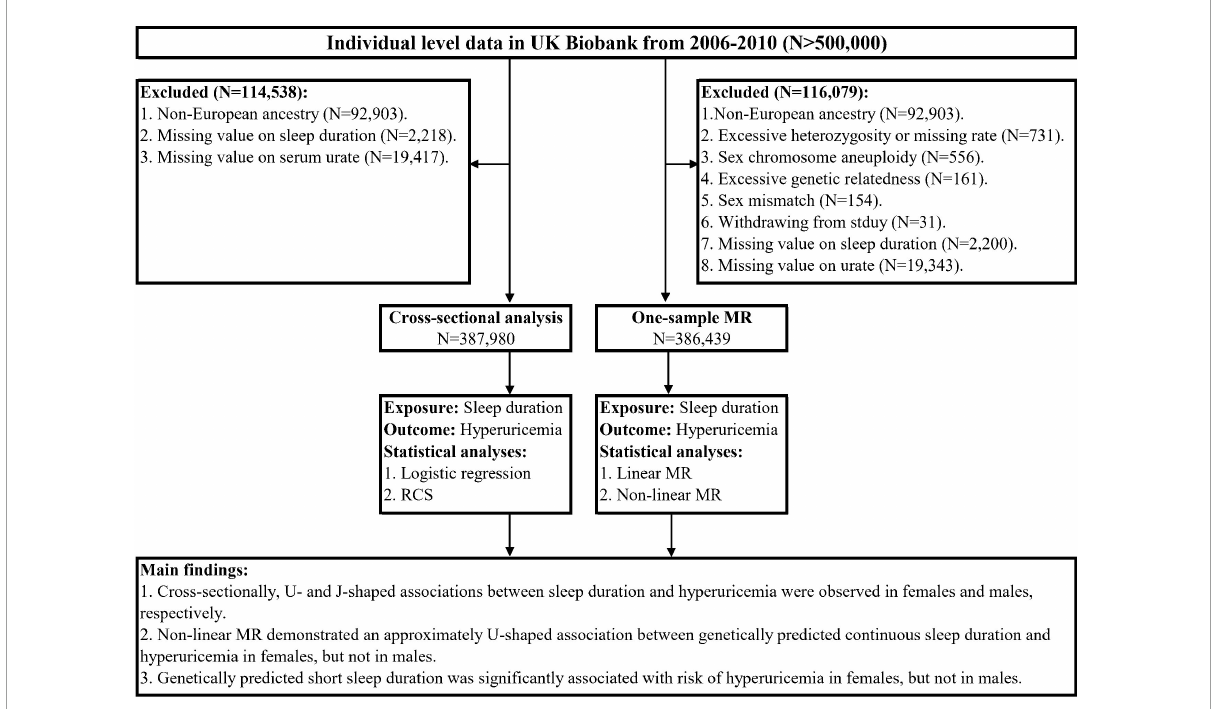
FIGURE1 The overall study design. MR, Mendelian randomization; RCS, restricted cubic spline.